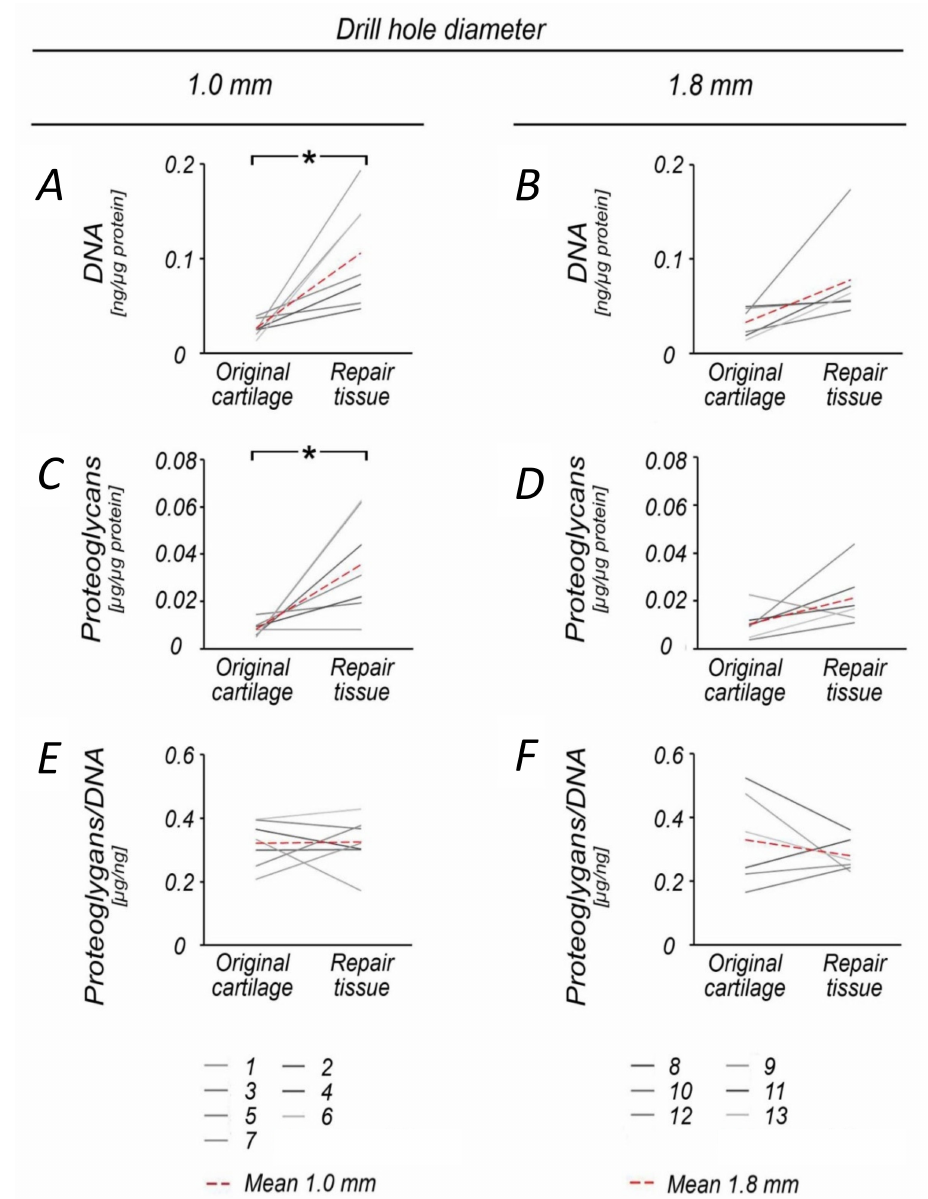
Figure 1. Comparison of proteoglycan and DNA content within original and repair cartilage following 1.0 and 1.8 mm subchondral drilling. Following 1.0 mm drilling, repair cartilage exhibited significantly increased DNA ( A ) and proteoglycan ( C ) content when compared with the original cartilage. In contrast, DNA and proteoglycan content was not significantly a ff ected in the group with 1.8 mm drilling ( B , D ). The proteoglycan / DNA ratio was balanced in the 1.0 mm group, ( E ) whereas it decreased in the 1.8 mm group ( F ). Numbers 1–13 represent individual animals. Red dotted lines indicate mean values. * p <